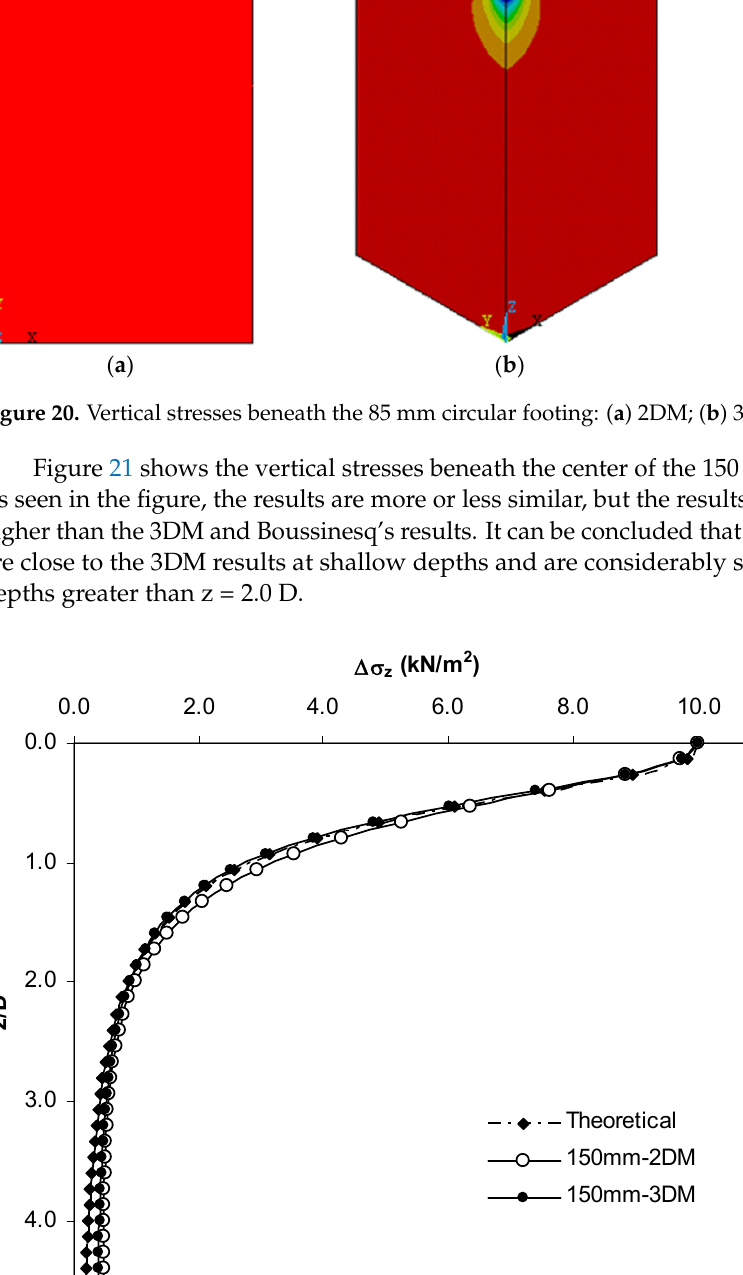
Figure 19. Vertical stress distribution (D = 85 mm).